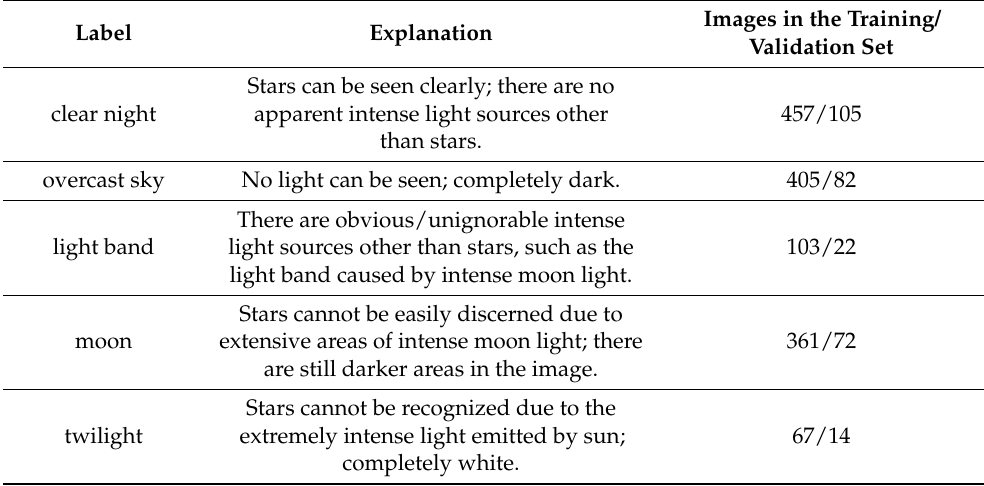
Table 1. Categories of images captured by all-sky airglow imager (ASAI).